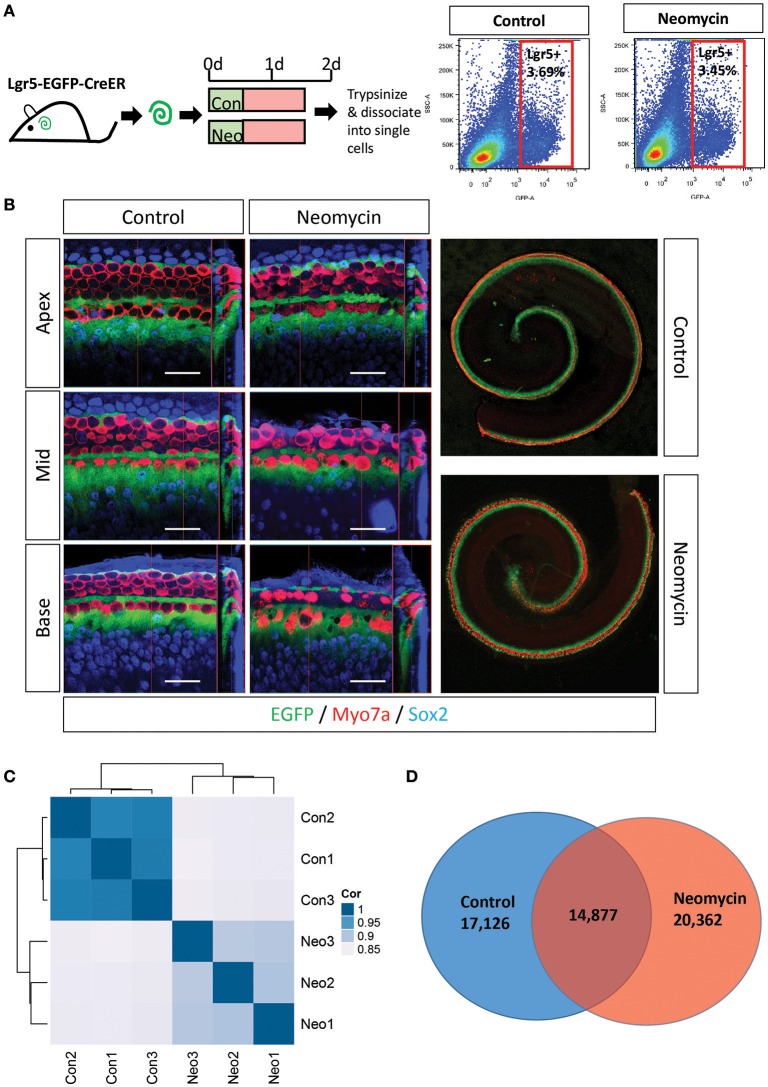
FACS sorting of Lgr5+ cells in the neomycin-treated and untreated cochleae of postnatal mice. (A,B) Neomycin was added for 12 h to the P1 Lgr5-EGFP-creER/Rosa26-tdTomato mouse cochleae, and the same amount of PBS was added to the untreated cochlear culture medium for the same amount of time. After a 24 h recovery period, the cochleae were trypsinized and dissociated into single cells for FACS sorting. (C) PCA analysis for all three replicates of NLPs (Neo1, Neo2, Neo3) and ULPs (Con1, Con2, Con3). (D) Venn diagram showing the number of genes expressed in NLPs (Neomycin) and ULPs (Control).